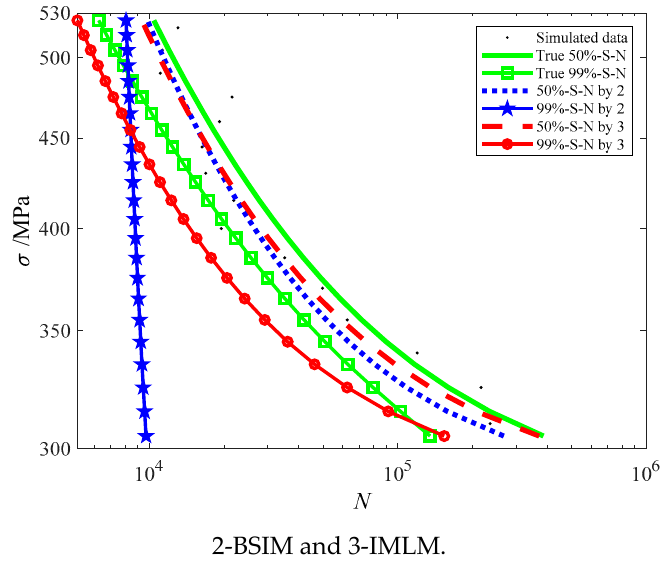
Figure 4. The fitting results of the first simulation set by BSIM and IMLM. (2) The second simulation test.